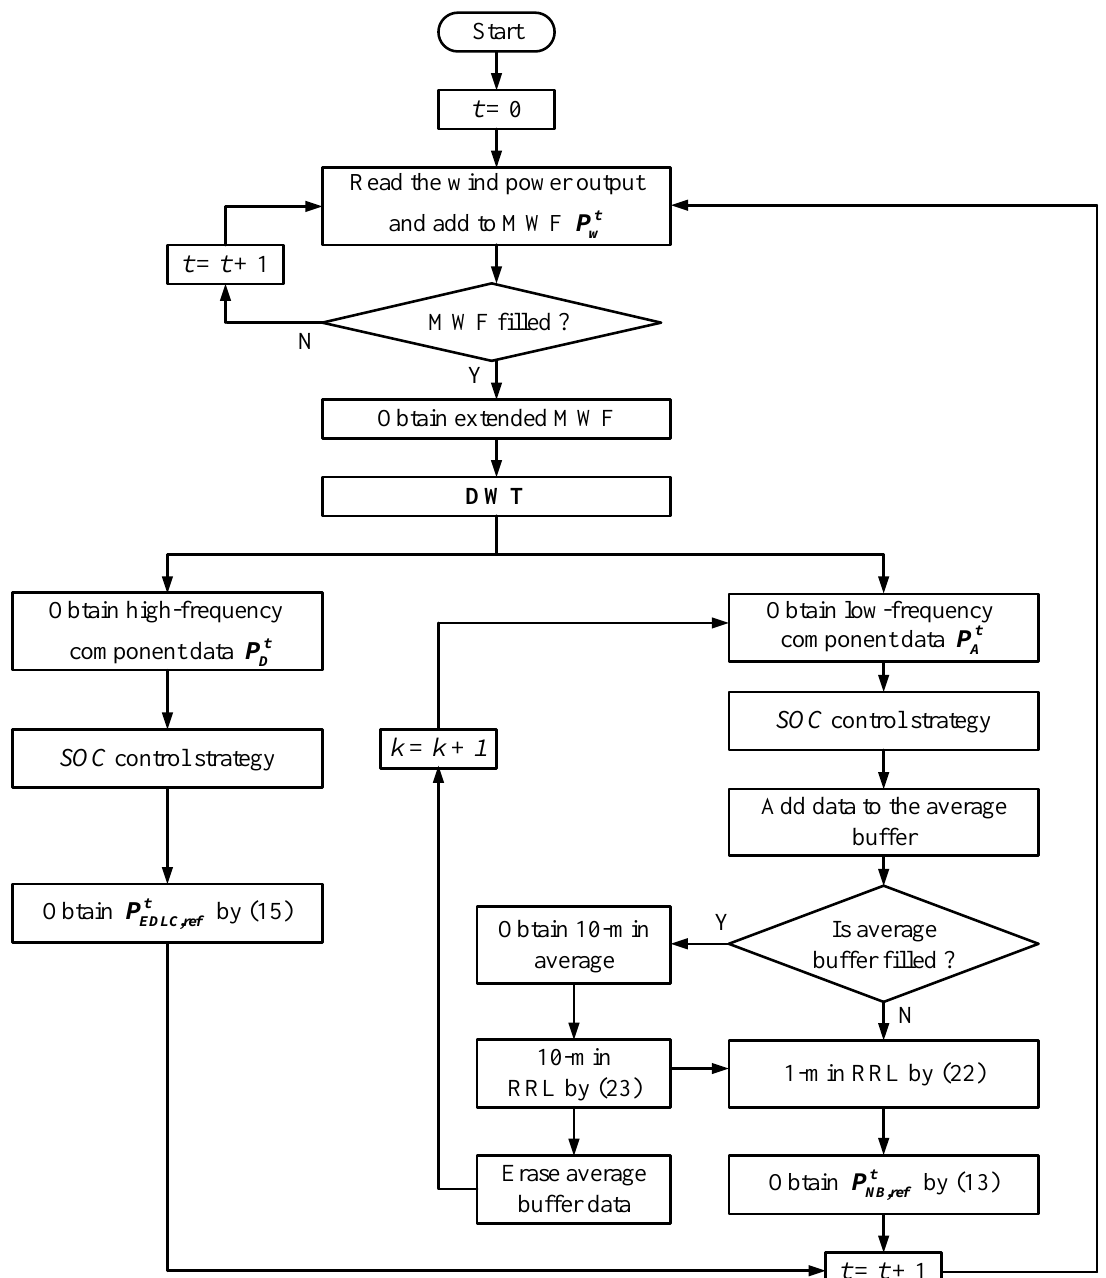
Figure 6. Flowchart of the complete real-time wavelet-based energy management algorithm (RWEMA). MWF: moving window function; DWT: discrete wavelet transform; and RRL: ramp rate